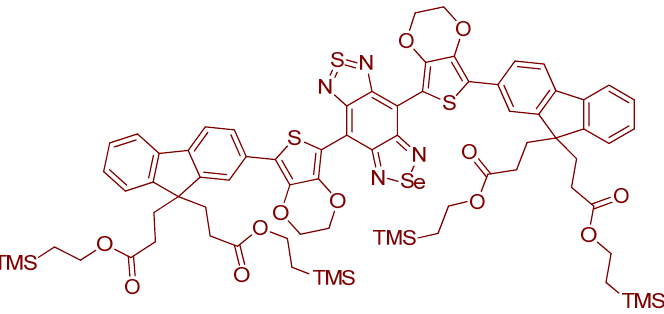
Figure 69. Structure of SY1080 synthesized by Zhang et al.